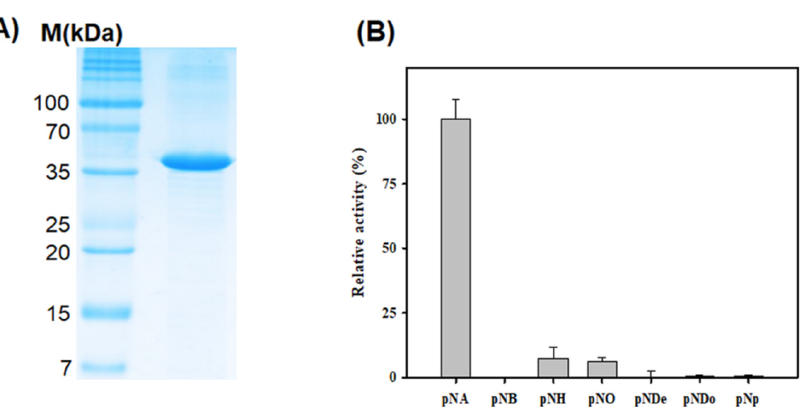
Figure 2. Purification and activity analysis of Lg EstI using various p -nitrophenyl esters. ( A ) SDS- PAGE analysis of Lg EstI purified by tag-affinity purification and size-exclusion chromatography. ( B ) The relative activities of Lg EstI against p -nitrophenyl esters, expressed as percentages. This activ- ity assay was carried out using various substrates ( p NA: p -nitrophenyl acetate; p NB: p -nitrophenyl butyrate; p NH: p -nitrophenyl hexanoate; p NO: p -nitrophenyl octanoate; p NDe: p -nitrophenyl de- canoate; p NDo: p -nitrophenyl dodecanoate; p NP: p -nitrophenyl phosphate). The activity of Lg EstI with p -nitrophenyl acetate was defined as